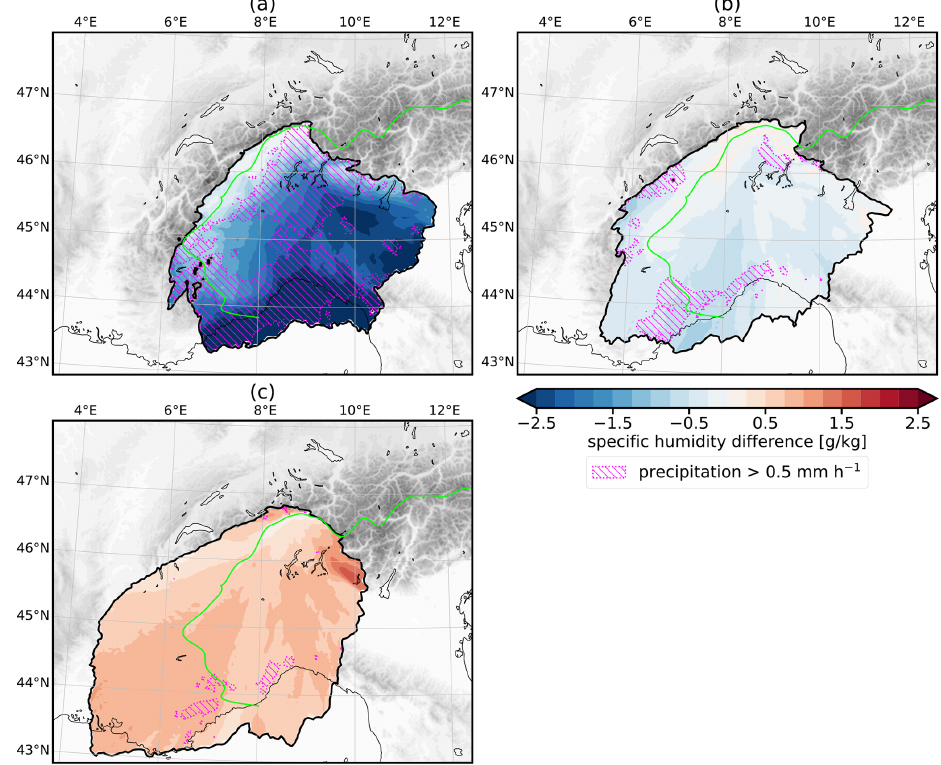
Figure 9. Binned trajectory maps with specific humidity changes relative to the crest (in colour) and precipitation exceeding 0.5mmh − 1 (as dashed violet areas) for the different trajectory clusters: (a) cluster 1; (b) cluster 2; (c) cluster 3. Areas with fewer than 1000 trajectory positions contributing to the mean are masked. See Fig. S6 for density maps depicting the number of trajectories within each bin. The crest line is indicated as a lime